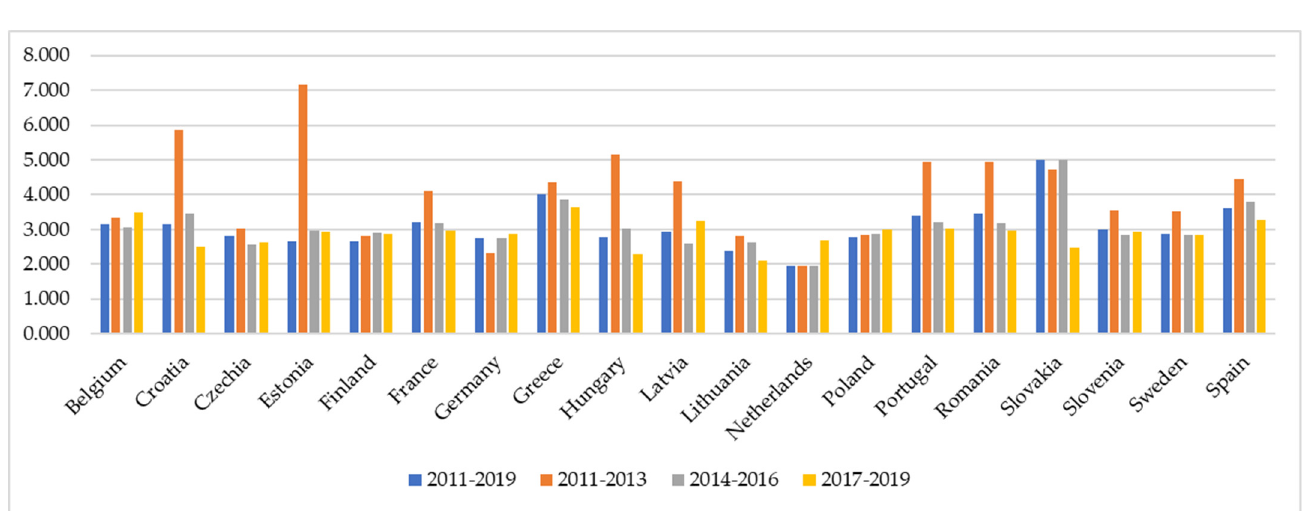
Figure A1. Solvency risk by country, full period, and three sub-periods—high solvency risk category. Note: the graph shows the median values of the TD/SF ratio.